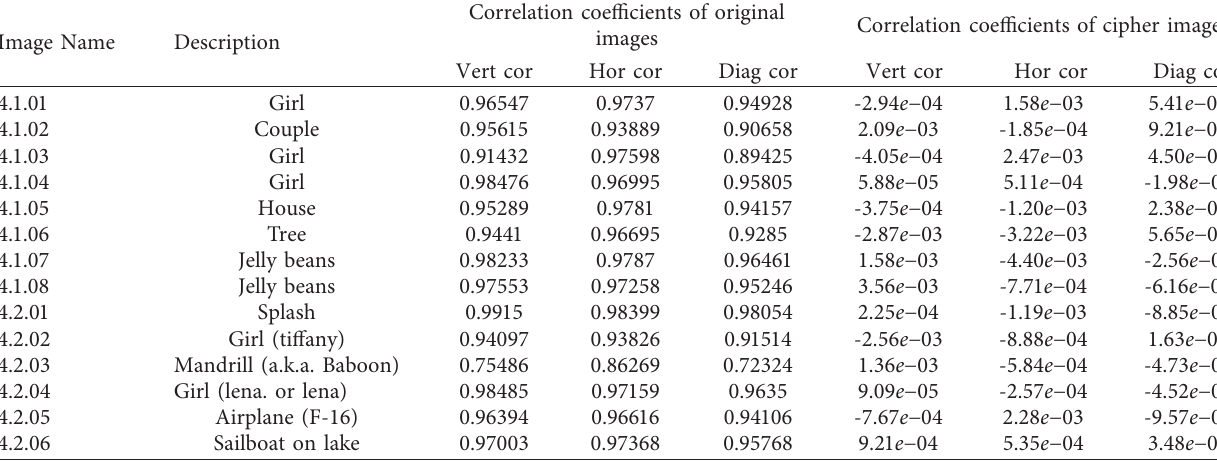
Table 6: Correlation coefficients between two vertically, horizontally, and diagonally adjacent pixels in several nonmedical plain images and also in their corresponding encrypted images from